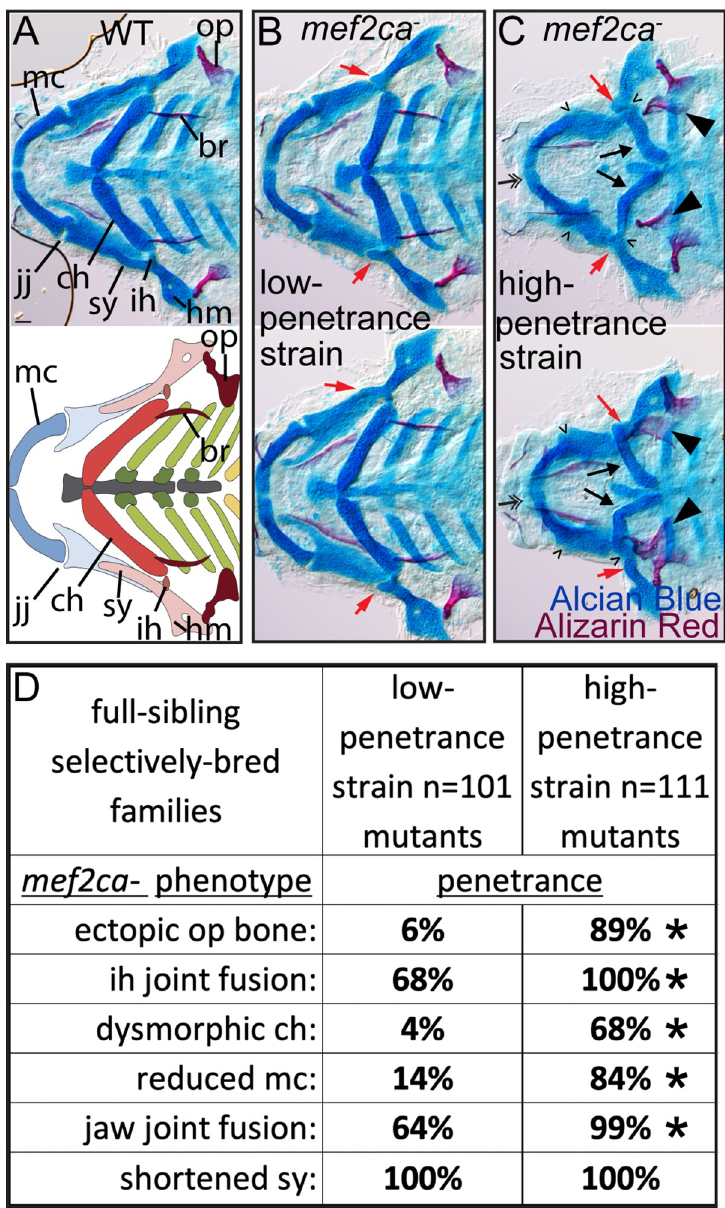
Fig 2. Selective breeding just for ectopic bone penetrance modifies penetrance of other mef2ca -associated craniofacial phenotypes to different extents. (A) Wild-type 6 days post fertilization (dpf) zebrafish larvae were stained with Alcian Blue and Alizarin Red to label cartilage and bone then flat mounted and imaged. The following craniofacial skeletal elements are indicated in the micrograph and graphic: opercle bone (op), branchiostegal ray (br), Meckel’s (mc), ceratohyal (ch), symplectic (sy) and hyomandibular (hm) cartilages, interhyal (ih) and jaw (jj) joints. Scale bar: 50 μ m. (B, C) Penetrance of most phenotypes associated with mef2ca are reduced in homozygous mutants from the low-penetrance strain compared to homozygous mutants from the high-penetrance strain including: ectopic bone (arrowheads), interhyal- and jaw-joint fusions (^), dysmorphic ch (arrows), reduced mc (double arrowhead). A shortened sy cartilage (red arrows) remains fully penetrant in both strains. (D) Penetrance of mef2ca -associated phenotypes from full-sibling low- and high-penetrance families. Asterisks indicate statistically significant penetrance differences between homozygous mutants in low-penetrance compared with high-penetrance strains (Fisher’s exact test at alpha = 0.05).